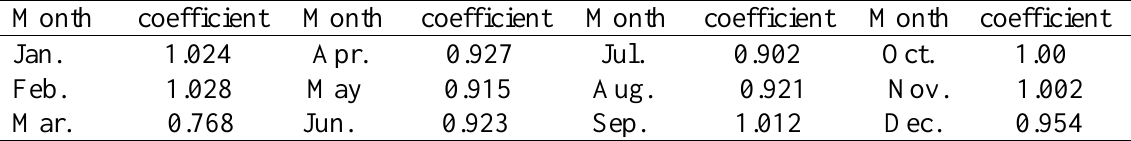
Table 1. Alternate factor for the months of the year for the GTA